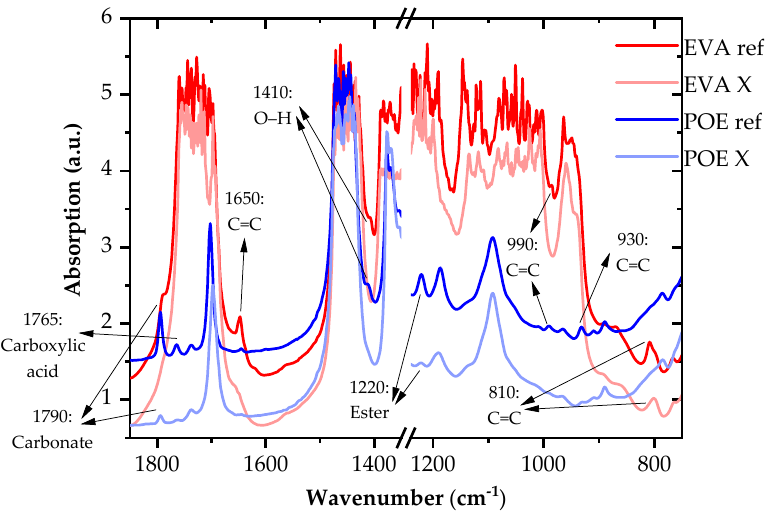
Figure 1. FTIR spectra of UV-transparent, fast-cure EVA and POE grades in the reference (ref) and fully crosslinked (X) state; decaying peaks or shoulders are numbered and highlighted with arrows.